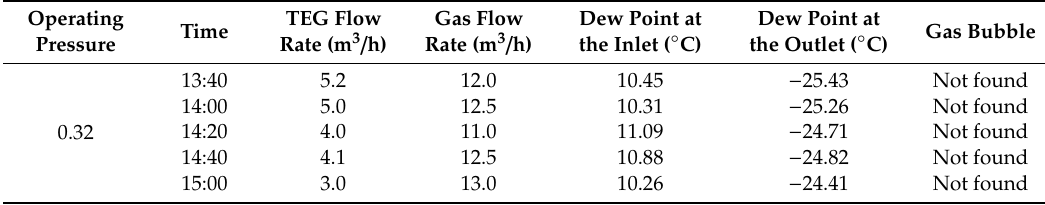
Table 8. Experimental results under conventional working